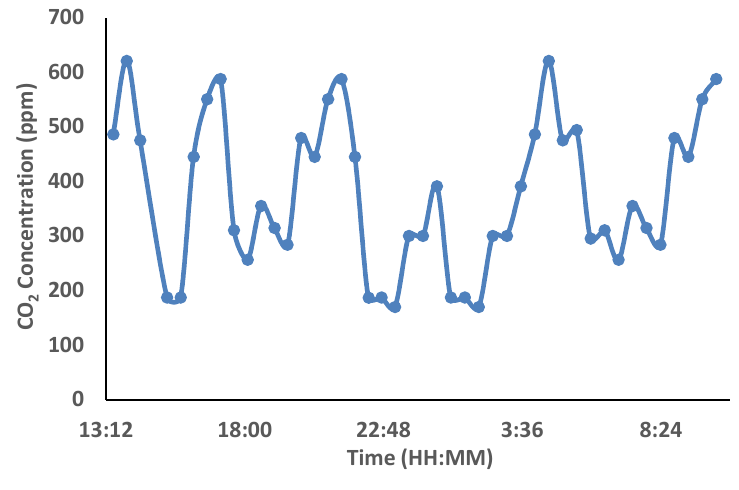
Figure 23. CO 2 Concentration.